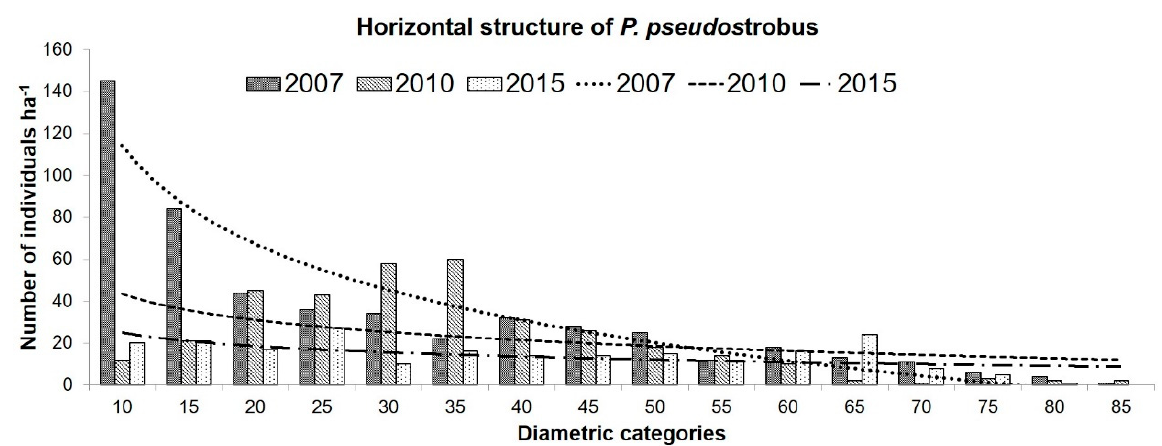
Figure 3. Horizontal structure of Pinus pseudostrobus in three different harvest years based on diameter distribution.